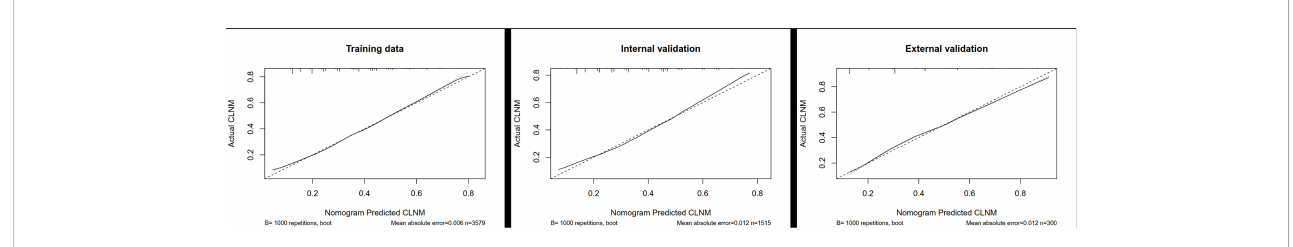
FIGURE 4 Calibration plot for our nomogram in the training cohort, internal cohort, and external cohort. CLNM, central lymph node